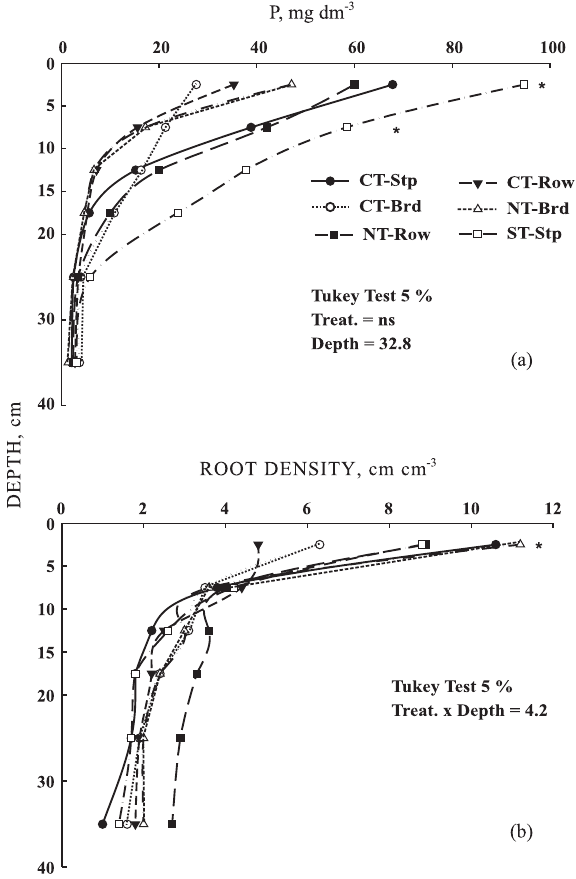
Figure 2. Phosphorus (Mehlich-1) (a) and root density (b) in a Rhodic Paleudult soil profile under different tillage systems for 18 years: Conventional - strip (CT-Stp), conventional – broadcast (CT/Brd), conventional – row (CT/ Row), no-tillage – broadcast (NT/Brd), no-tillage – row (NT/Row) and Strip – Strip (ST/Stp), 2006/ 2007 growing